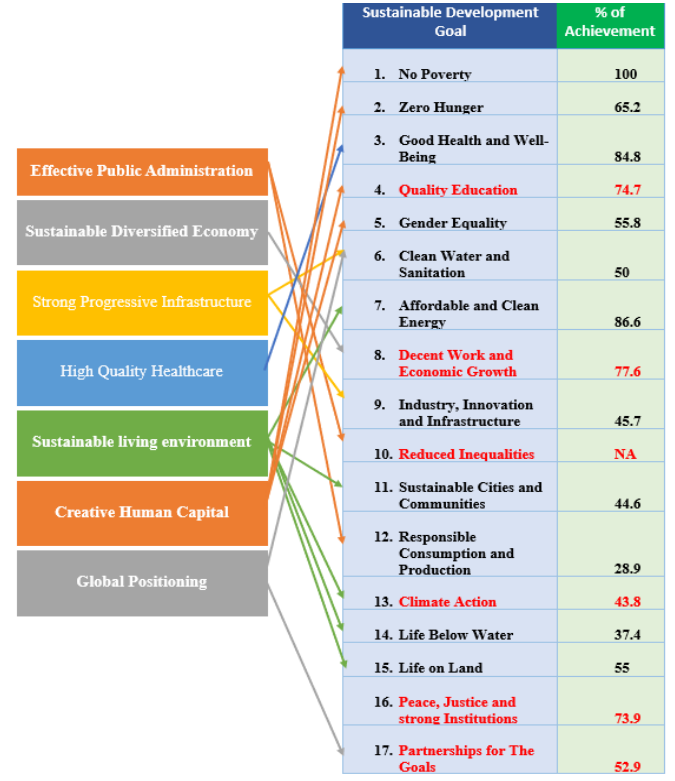
Figure 3. Mapping the Kuwait National Institutional Development Plan to SDGs adopted from the Kuwait Voluntary National Review [37].